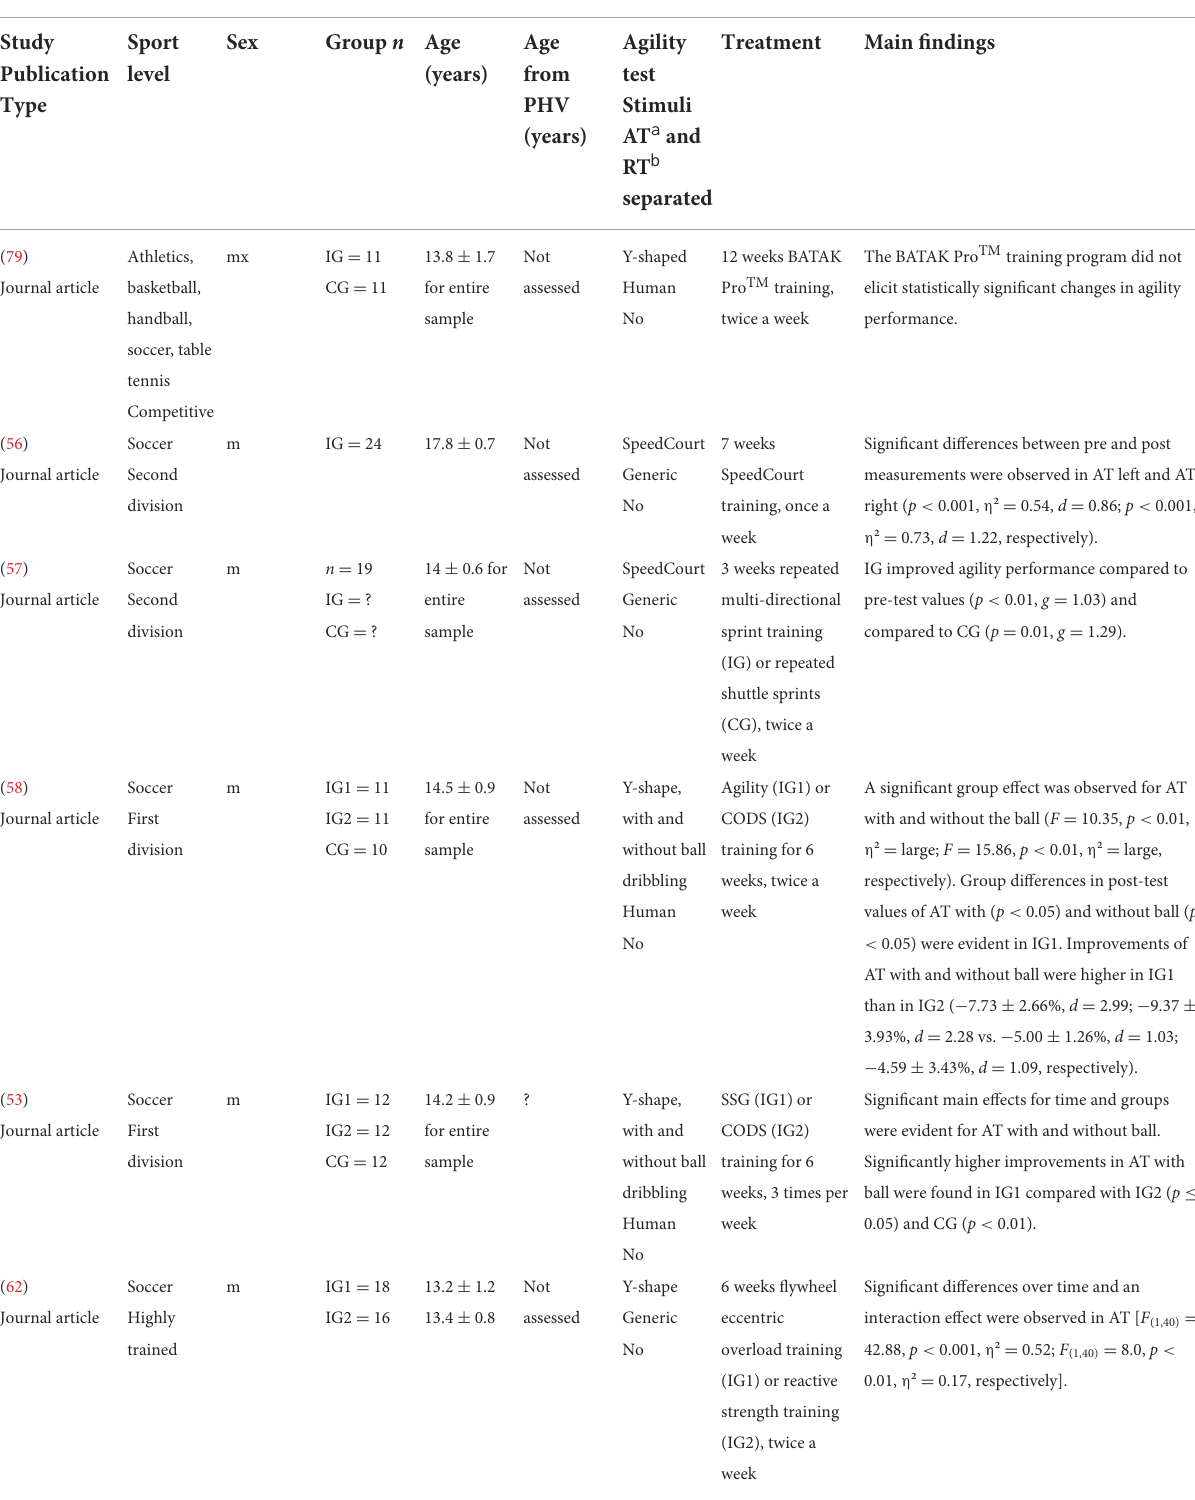
TABLE 2 Characteristics and outcomes of included experimental